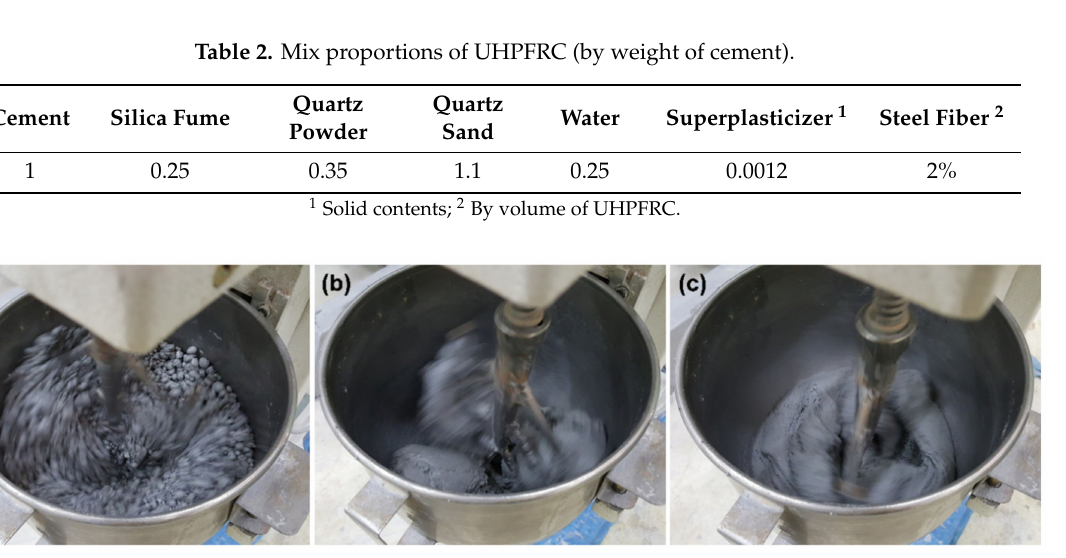
Figure 2. Manufacturing process of UHPFRC: ( a ) formation of small grains by local agglomeration; ( b ) agglomeration of small grains into large lumps; ( c ) dispersion after solid-suspension